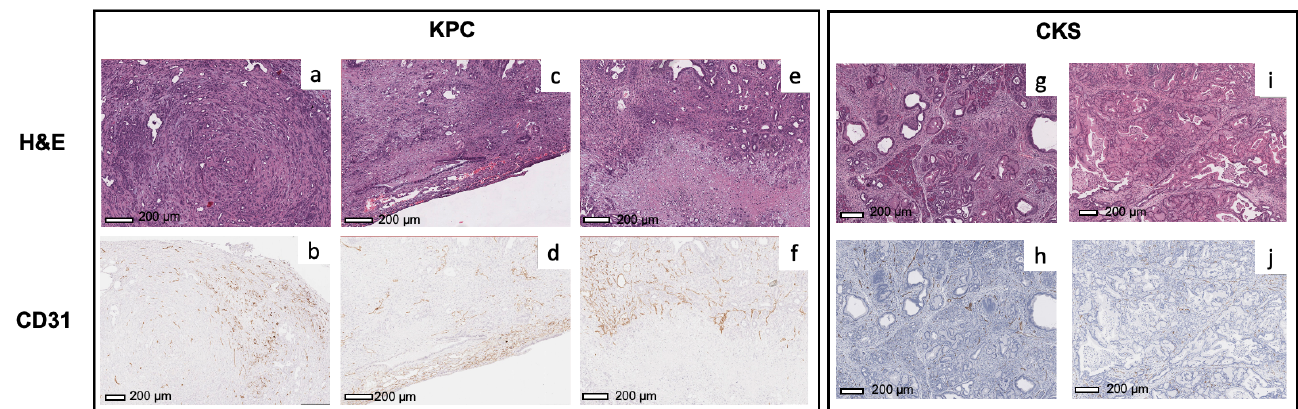
Figure 6. CD31 staining of KPC and CKS tumor. CD31 stained micrographs are shown for two KPC tumor specimens ( b , d , f ) with the corresponding H&E micrographs from adjacent sections ( a , c , e ). CD31 stained micrographs are shown for two CKS tumor specimens ( h , j ) with the corresponding H&E micrographs ( g , i ). The blue tint in CKS slides from hematoxylin counter staining does not interfere with quantification of microvasculature density by the classifier.